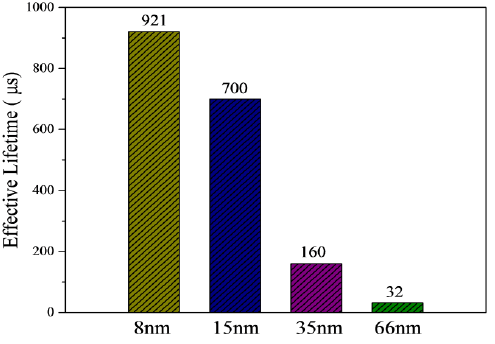
Figure 6. Minority carrier lifetime at injection level 1 × 10 15 cm − 3 for different thicknesses of ALD TiO 2 thin films deposited at 200 °C: 8 nm, 15 nm, 35 nm, and 66 nm.